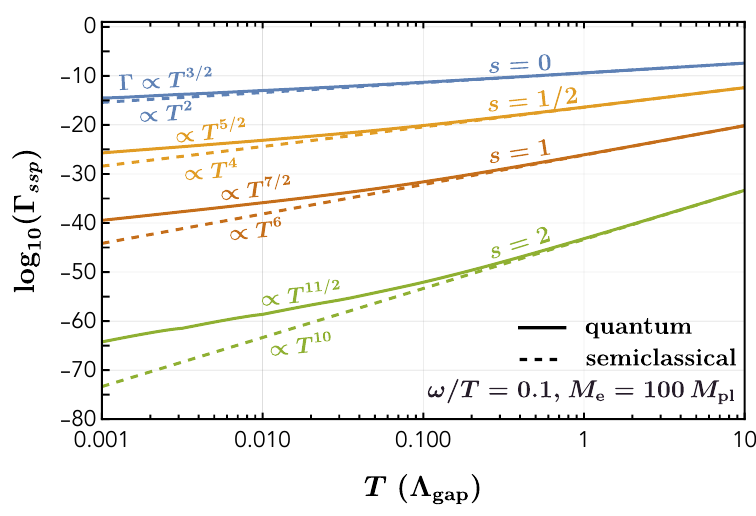
Figure 2 . Greybody factors Γ ssp as function of T for massless particles with different spins for M e = 100 M pl and ω/T = 0 . 1 . The quantum corrected ones from (3.6) and with a scaling of Γ ssp ∝ T 2 s +3 / 2 in the limit of T (cid:28) Λ gap are shown in solid lines, while the semiclassical results from (3.2) and with a scaling of Γ ssp ∝ T 4 s +2 are shown in dashed